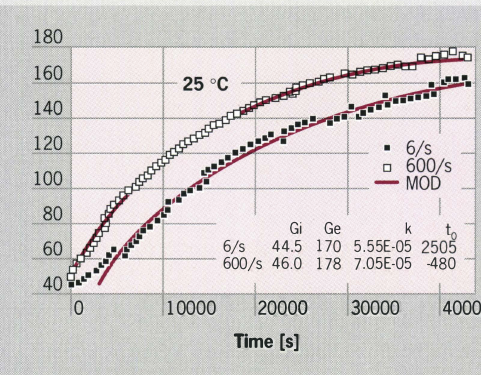
Abb. 5: Verlauf der FlieBaktivierungsenergie wiihrend der Abkiihlung von Maisstiirkepasten. Fig. 5: Evolution of activation energy of flow during cooling of maize starch